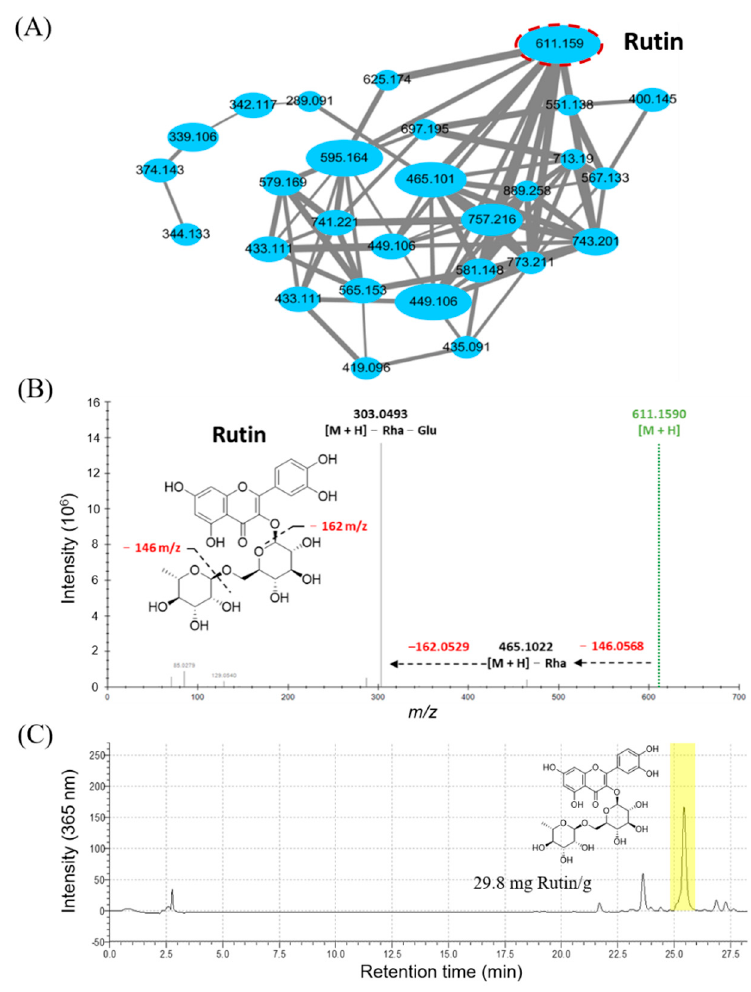
Figure 1. Metabolomic analysis of djulis hull crude extract. ( A ) Flavonoid glycosides-related cluster. ( B ) MS/MS fragmentation of rutin. ( C ) HPLC profiling (365 nm) of djulis hull crude extract.